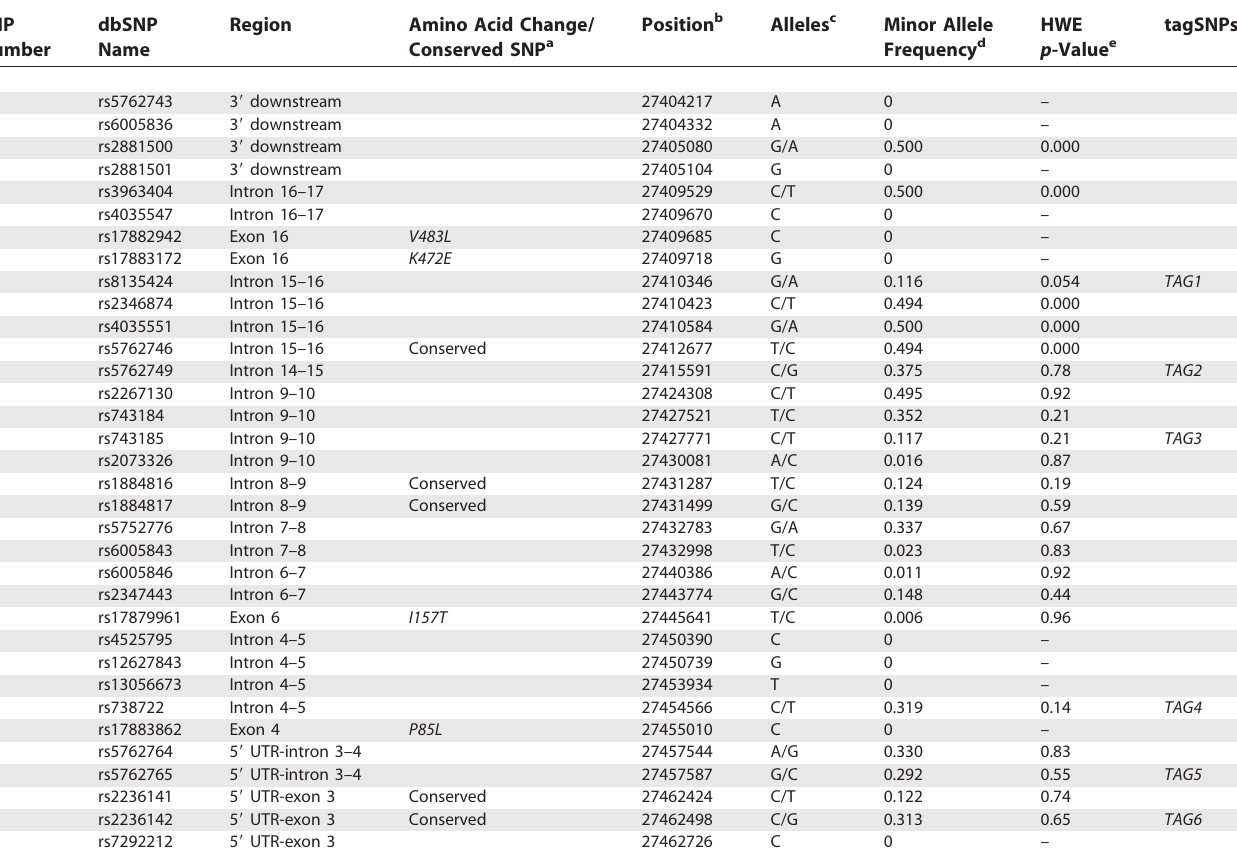
Table 2. Summary Data on 34 SNPs in CHEK2 and Its 5-kb Flanking Sequences Successfully Genotyped in 92 Swedish Controls